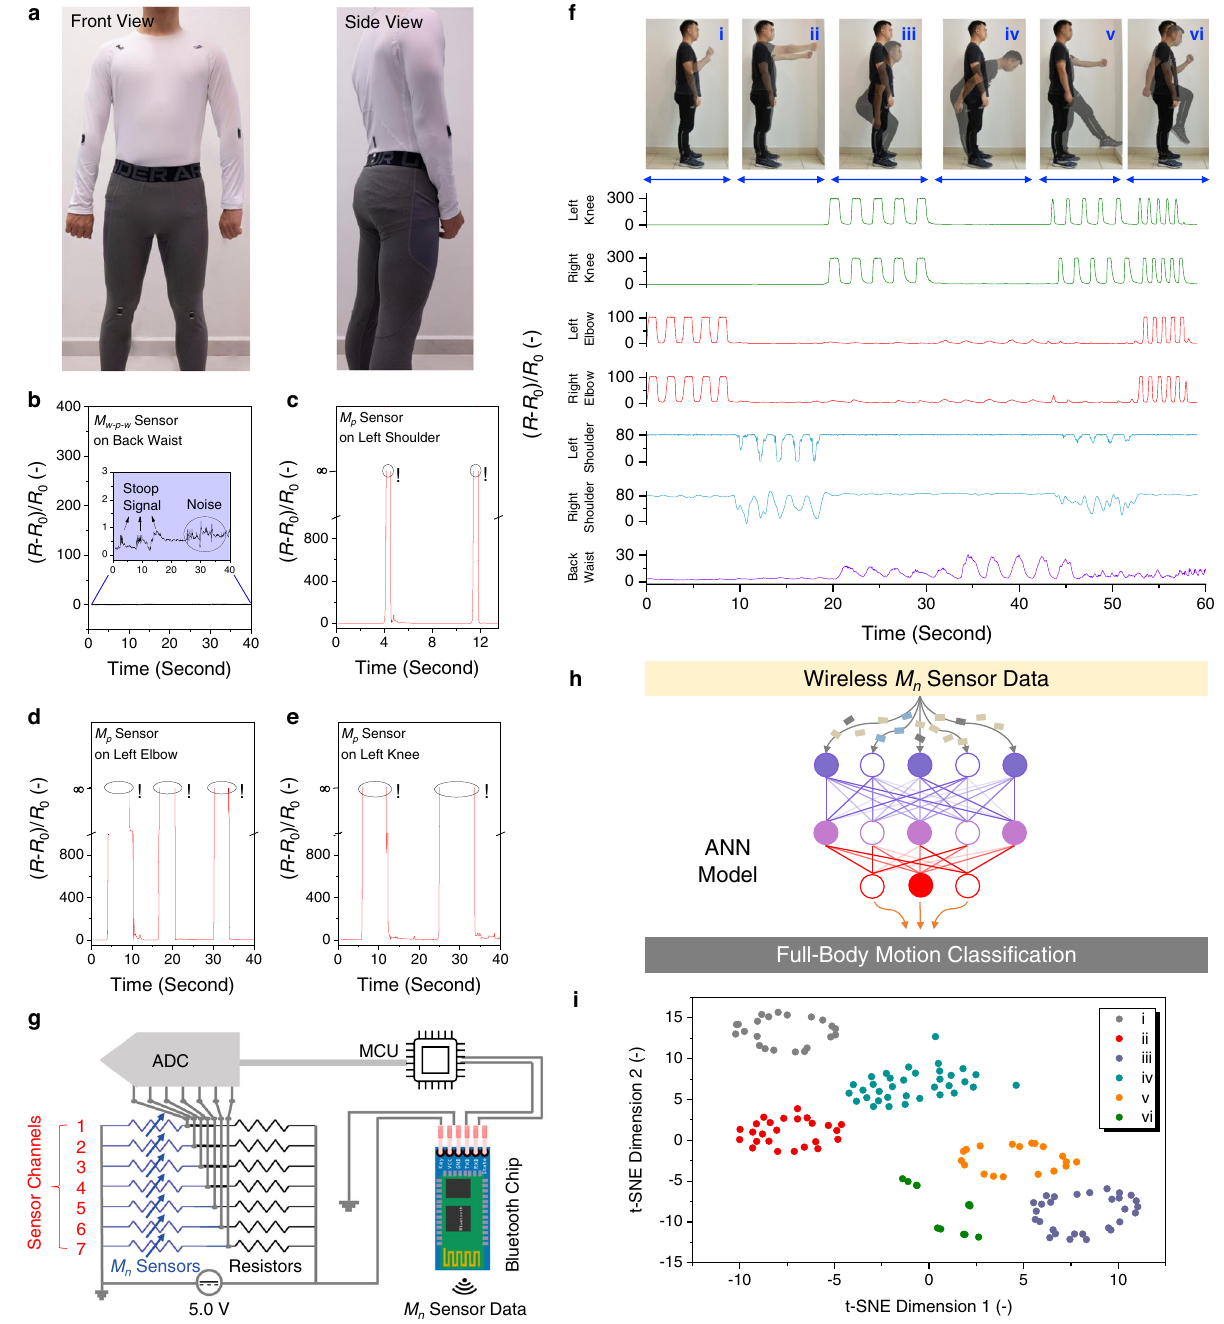
lost their strain sensing capabilities. f Signal outputs, S ε , of seven M n sensors for full-body motion monitoring, including (i) left/right elbow lifting, (ii) left/right shoulder lifting, (iii) squatting, (iv) stooping, (v) walking, and (vi) running. g Equivalent circuit of a wireless sensor module. h M ulti-channeled M n